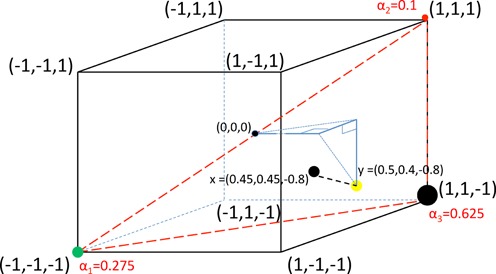
Single recombinant search with partially explained data. Here the data point y = (0.5, 0.4, −0.8) does not lie in a triangle spanned by DWV, VDV-1 and any other vertex. All vertices other than DWV and VDV-1 can be searched and the vertex, here (1, 1, −1), providing the minimum distance selected, it being the most likely single mosaic. The nearest point to y in this red triangle is x = (0.45, 0.45, −0.8) with barycentric coordinates α = (0.275, 0.1, 0.625). The minimum distance is 0.0707, small relative to the diameter of the cube, \documentclass[12pt]{minimal}
\usepackage{amsmath}
\usepackage{wasysym}
\usepackage{amsfonts}
\usepackage{amssymb}
\usepackage{amsbsy}
\usepackage{upgreek}
\usepackage{mathrsfs}
\setlength{\oddsidemargin}{-69pt}
\begin{document}
}{}$2\sqrt{3}=3.4641$\end{document}.